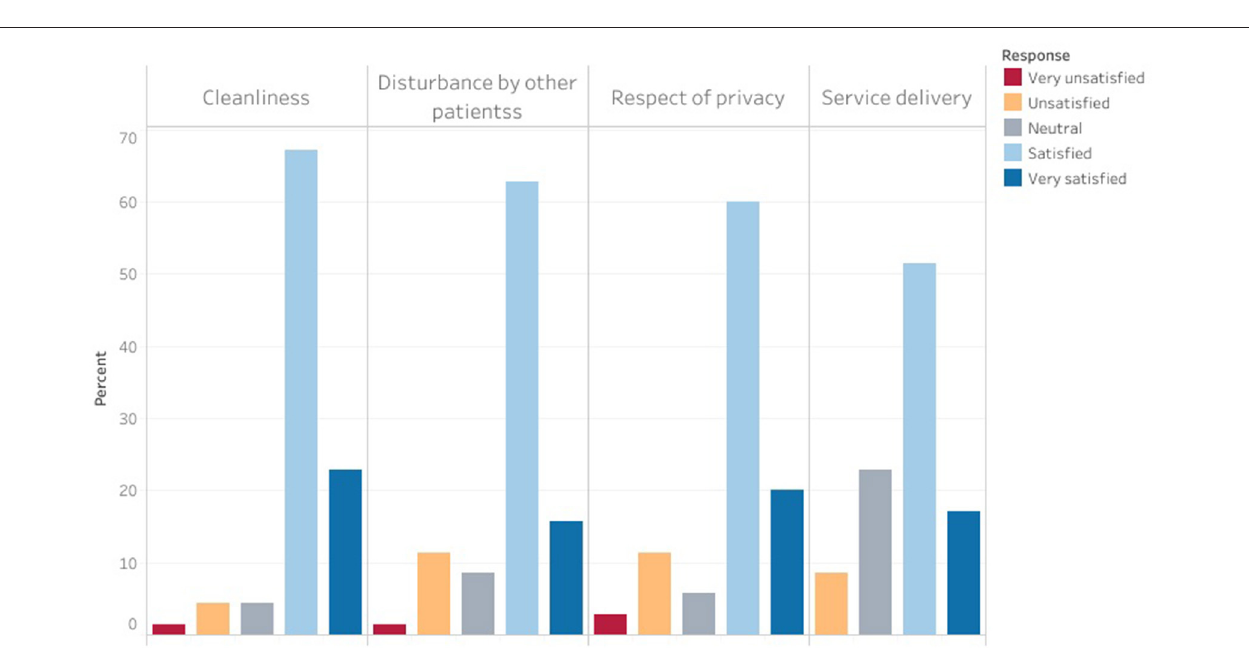
FIGURE 5 | Neurosurgery patient satisfaction with service delivery and the care